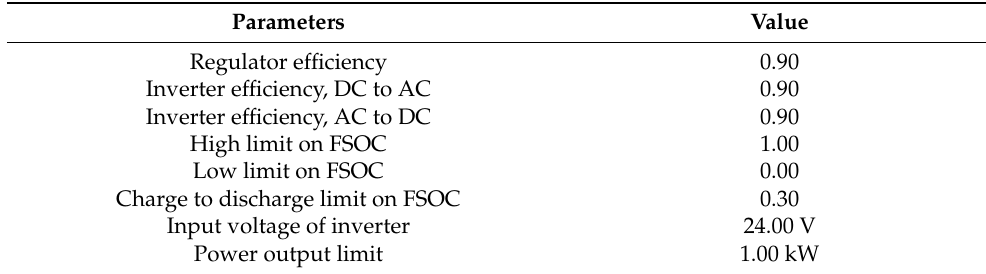
Table 4. Technical data of regulator and